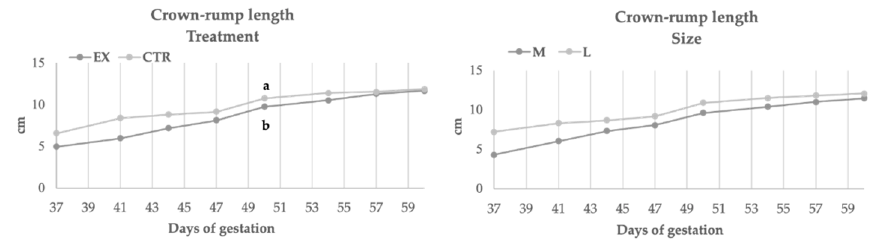
Figure 5. Crown-rump length during gestation in function of diets and size. EX: experimental group CTR: control group; a, b: p < 0.05.